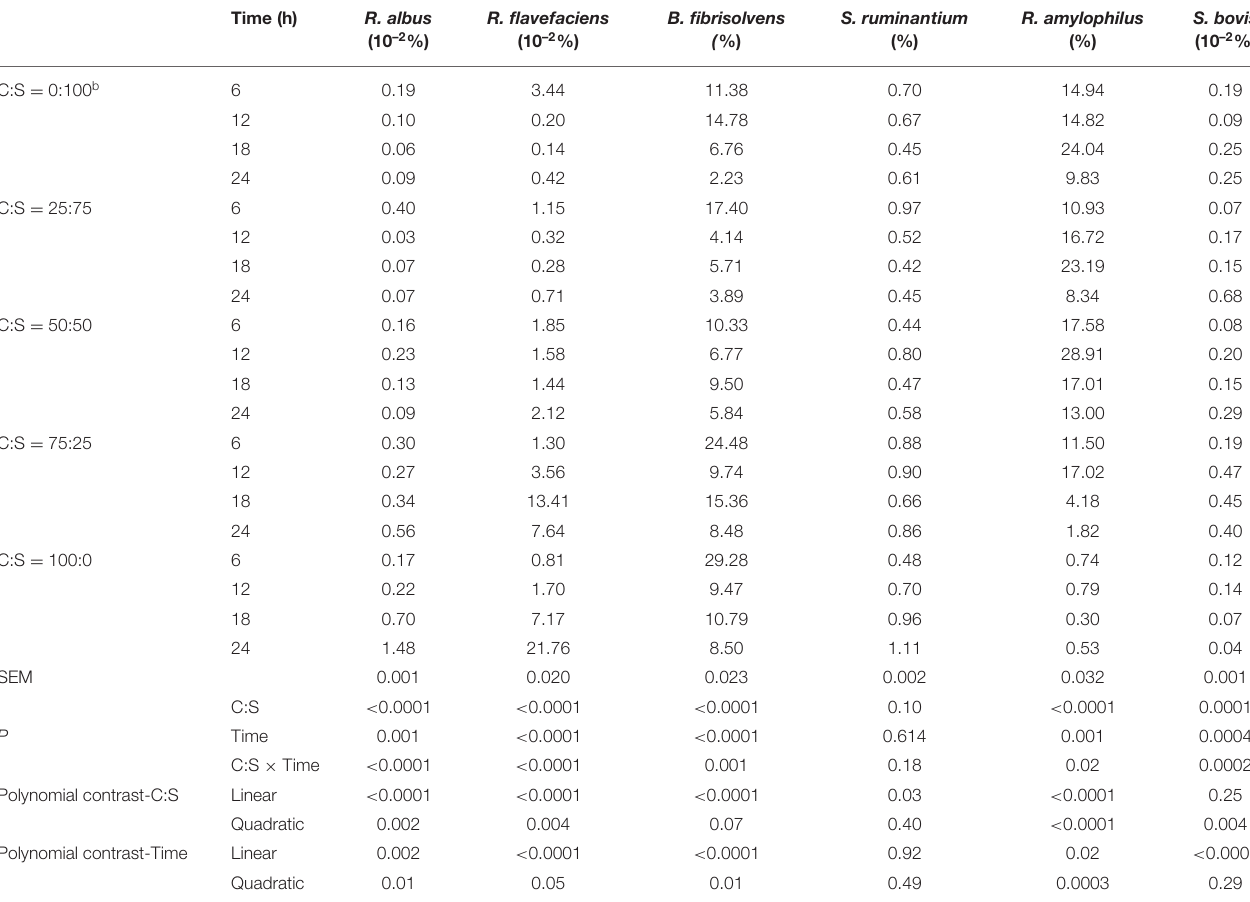
TABLE 5 | Effect of different ratios of cellulose and starch (C:S) on ruminal bacteria populations a during 24 h of incubation in vitro . Time